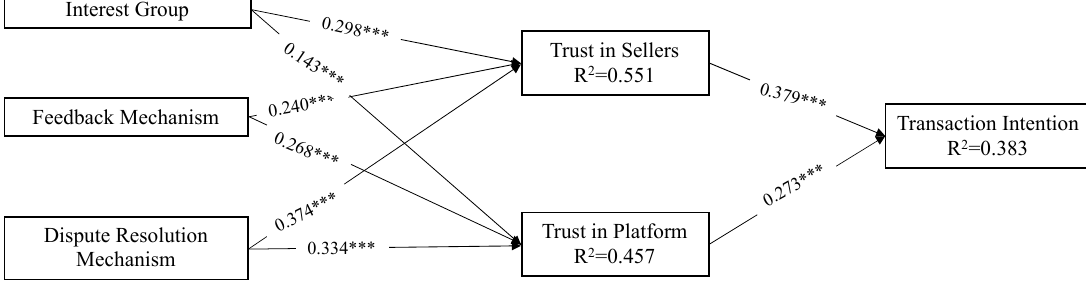
Figure 2. Full Sample Analysis Results. Note: *** represents at 0.001 level ( p < 0.001). The obtained model path coefficients and hypothesis test results are presented in Table 4. Table 4. Structural model results.